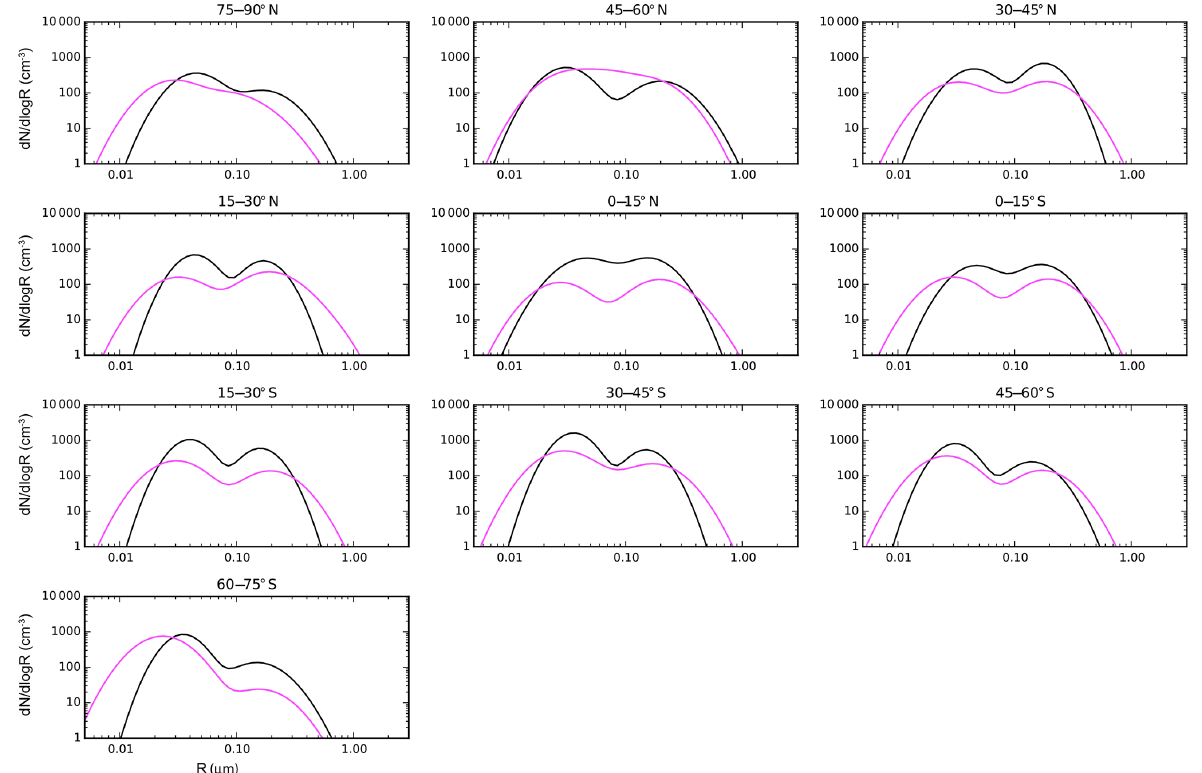
Figure 10. Size distribution of simulated (pink lines) and measured (black lines) aerosol number in the marine boundary layer for the NUDGE simulation. The observed size distribution corresponds to a 30-year climatology for the Aitken and accumulation modes (soluble and insoluble) (Heintzenberg et al., 2000). The simulated size distributions correspond to a 10-year annual average over the locations of the measurements and zonally averaged between the given latitude